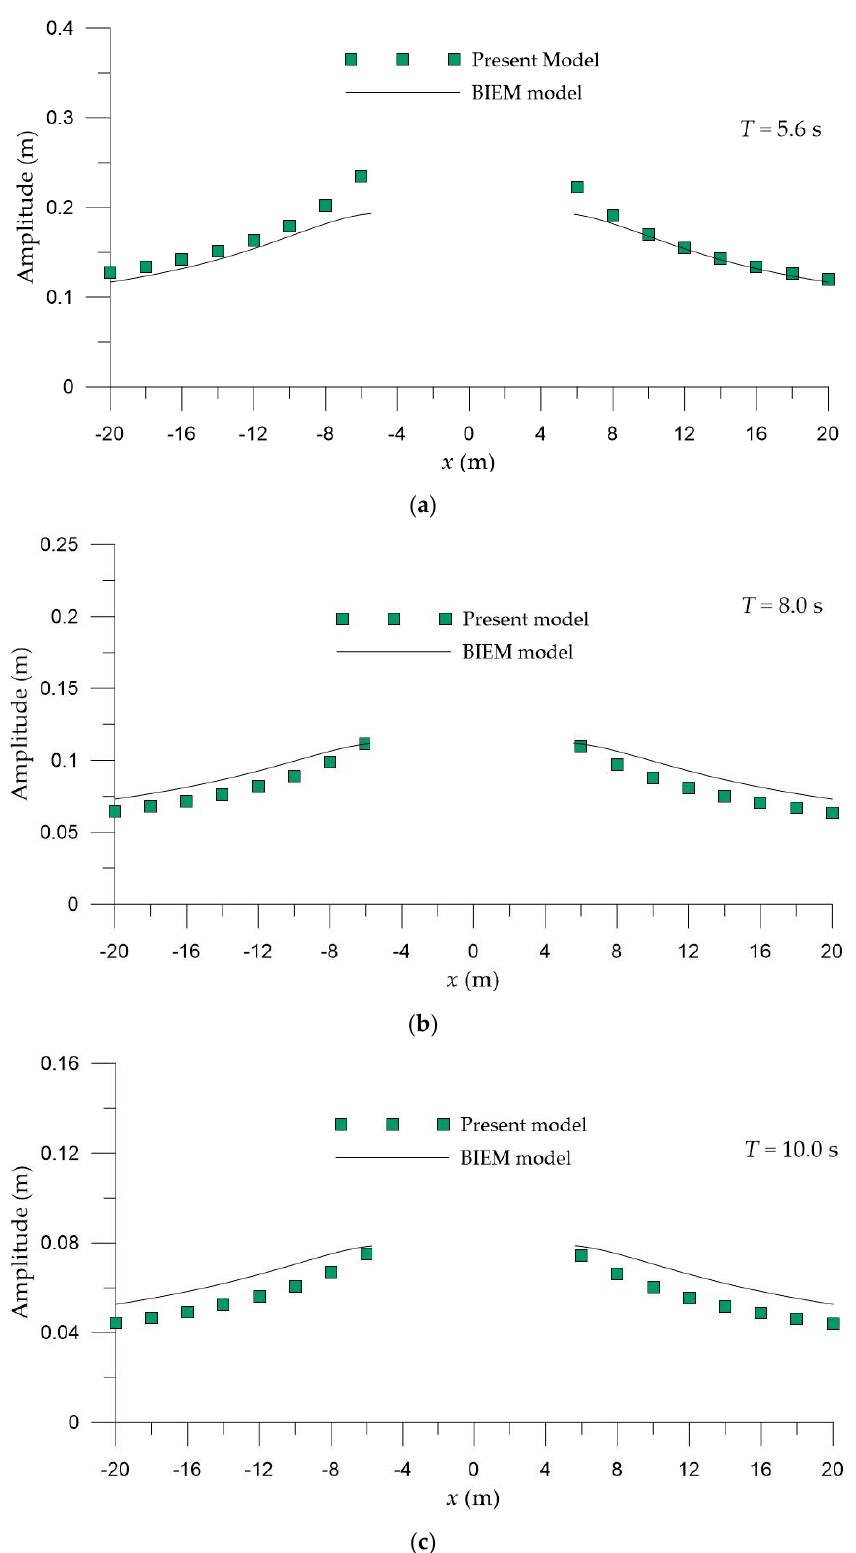
Figure 4. Variation of free-surface amplitude along the x axis due to waves generated by a forced unit-amplitude sinusoidal motion in heave of a cylinder with a = 5.0 m and b / a = 1.0 placed at d = 10 m: ( a ) T = 5.6 s; ( b ) T = 8.0 s; ( c ) T = 10.0 s. In all plots, the cylinder lies at − 5.0 m ≤ x ≤ 5.0